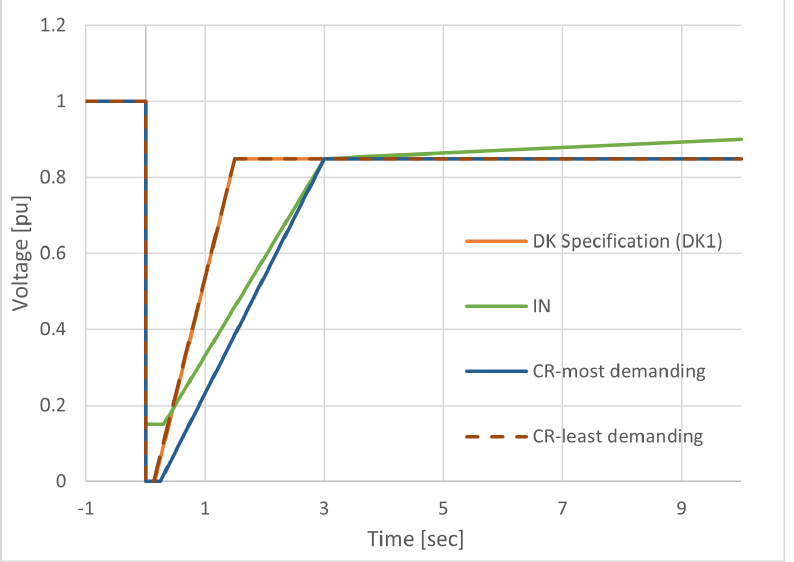
Figure 2. Under voltage ride-through capability for generating units and storage in Denmark (DK) and India (IN) shown together with the most and least demanding capability allowed for TSOs in Europe as per Commission Regulation(EU